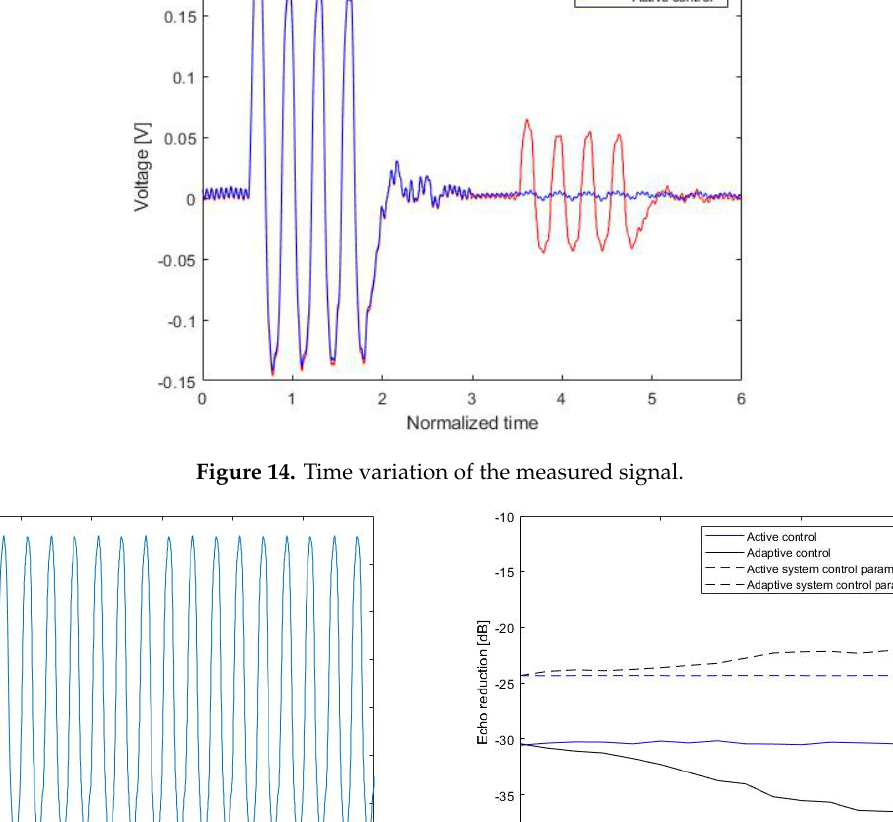
( b ) Figure 16. Adaptive control for a change of frequency: ( a ) a continuous input signal and ( b ) the echo reduction rate and system control parameter. 7. Conclusions This paper presents a multilayer piezoelectric acoustic absorber system with high echo reduction at low frequencies. Despite the separation of the incident signal from the two sensor signals through a time-delay signal separation method, the absorber system cannot respond precisely to